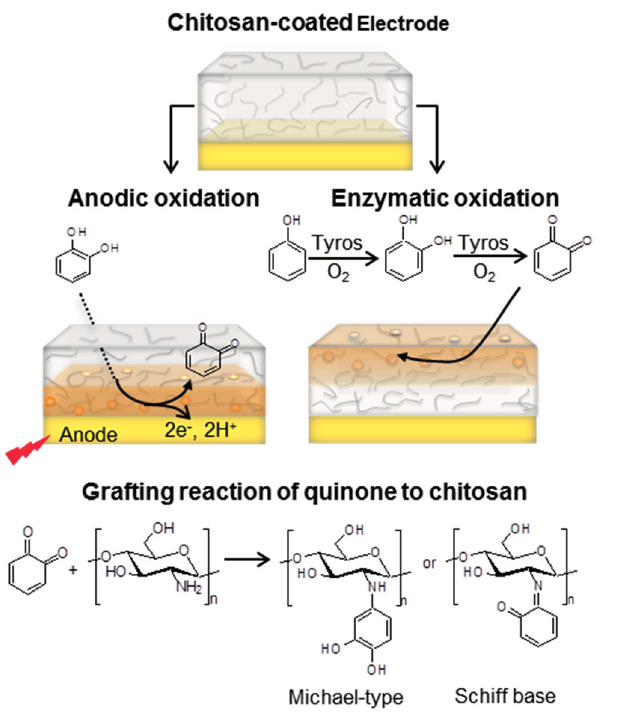
Figure 14. Grafting of catechols to chitosan films using anodic or enzymatic oxidation to generate reactive o -quinones that can undergo subsequent uncatalyzed reactions. Reproduced with permission from [233], published by Royal Society of Chemistry,